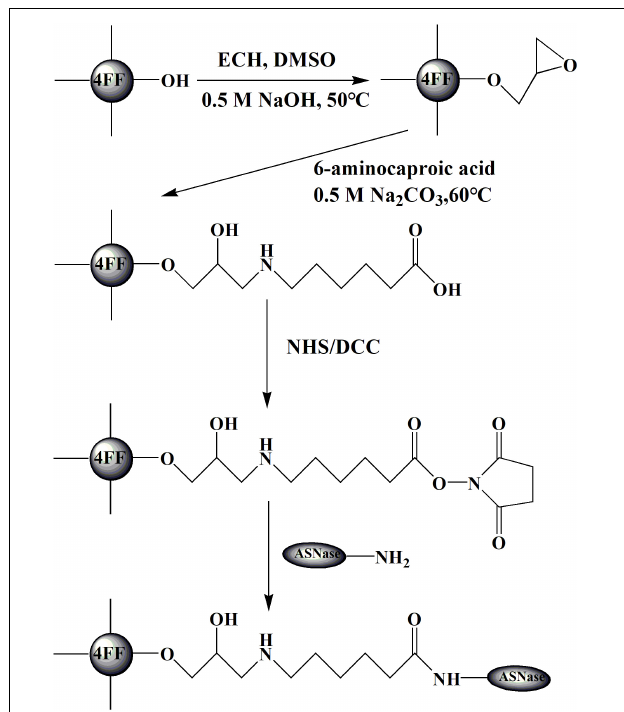
FIGURE 1 | Procedures of modification and